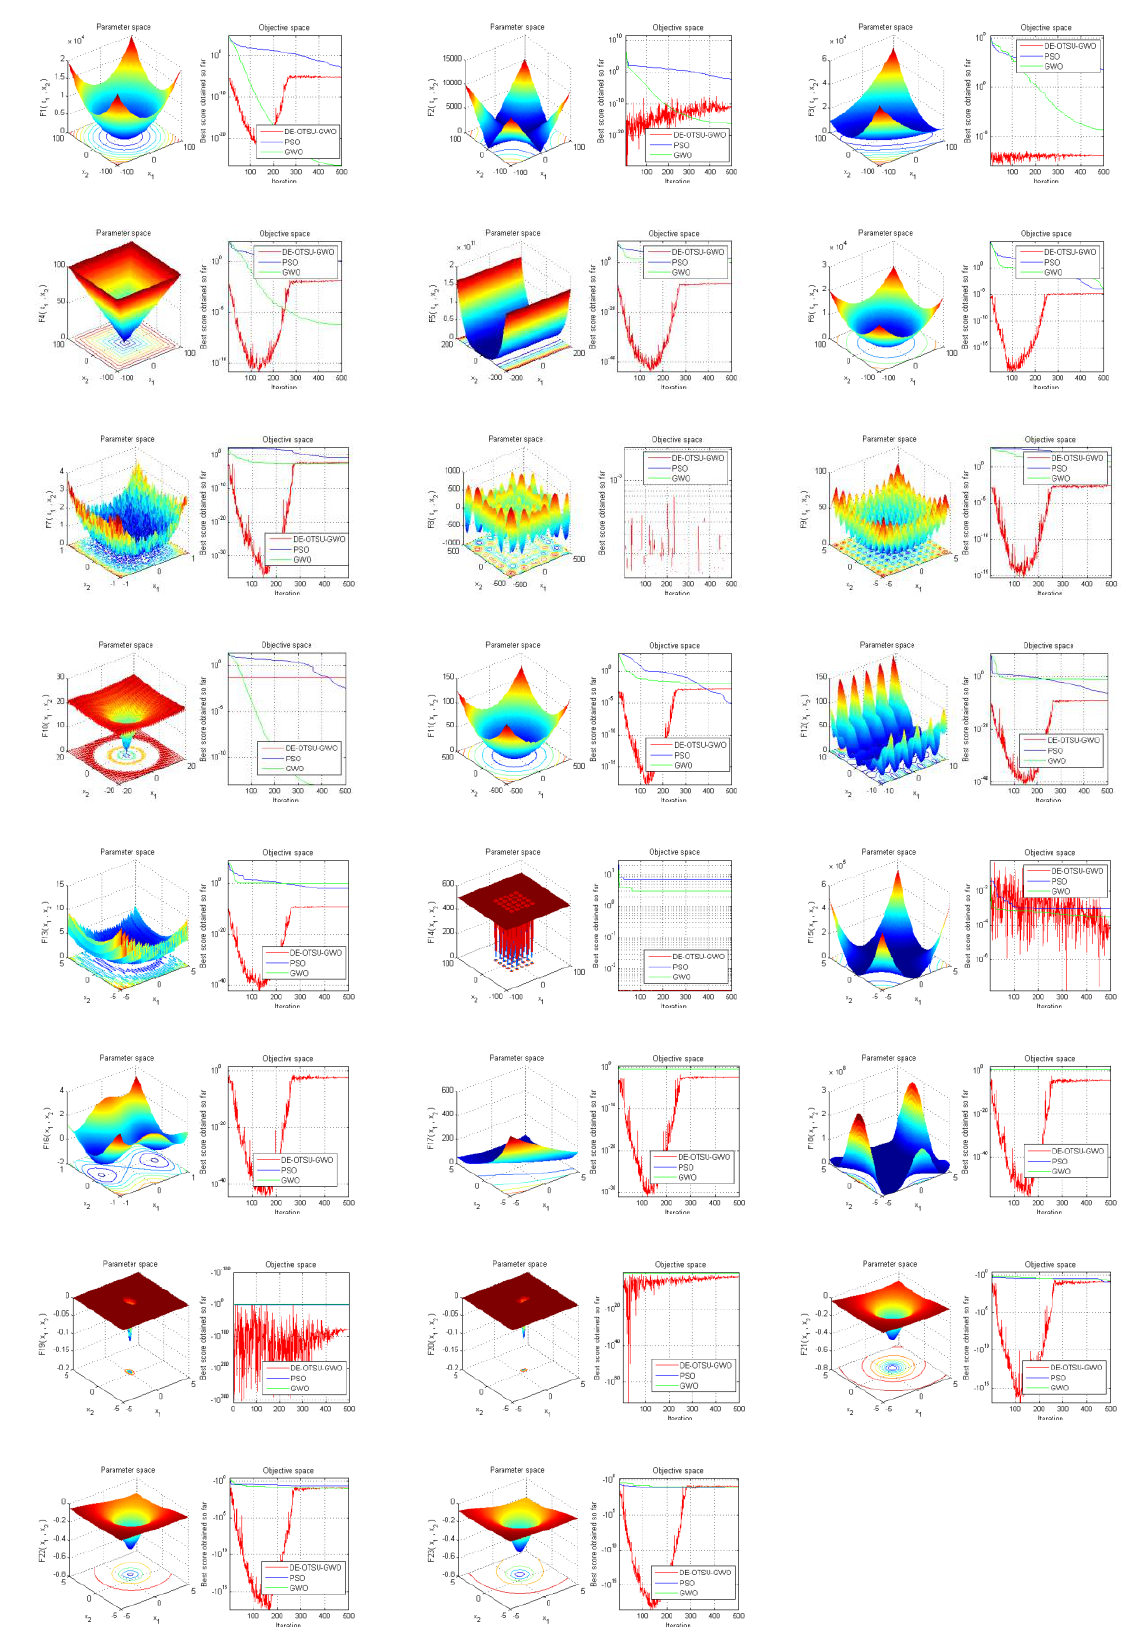
Figure 4. The changes in the iterative process of the three algorithms. 4. DE−OTSU−GWO Algorithm for Classical Agricultural Image Recognition Problems